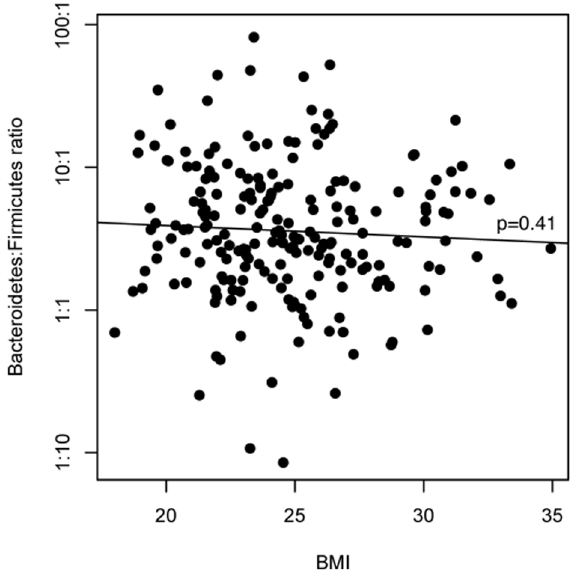
Figure 1. There is no association between BMI and the Bacteroidetes : Firmicutes ratio in HMP stool microbiomes.